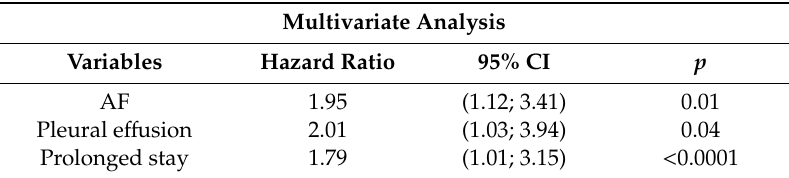
Table 5. Hyponatremia-related factors.